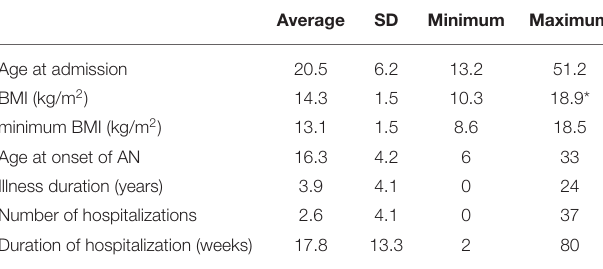
TABLE 1 | Clinical characteristics of the sample ( n =